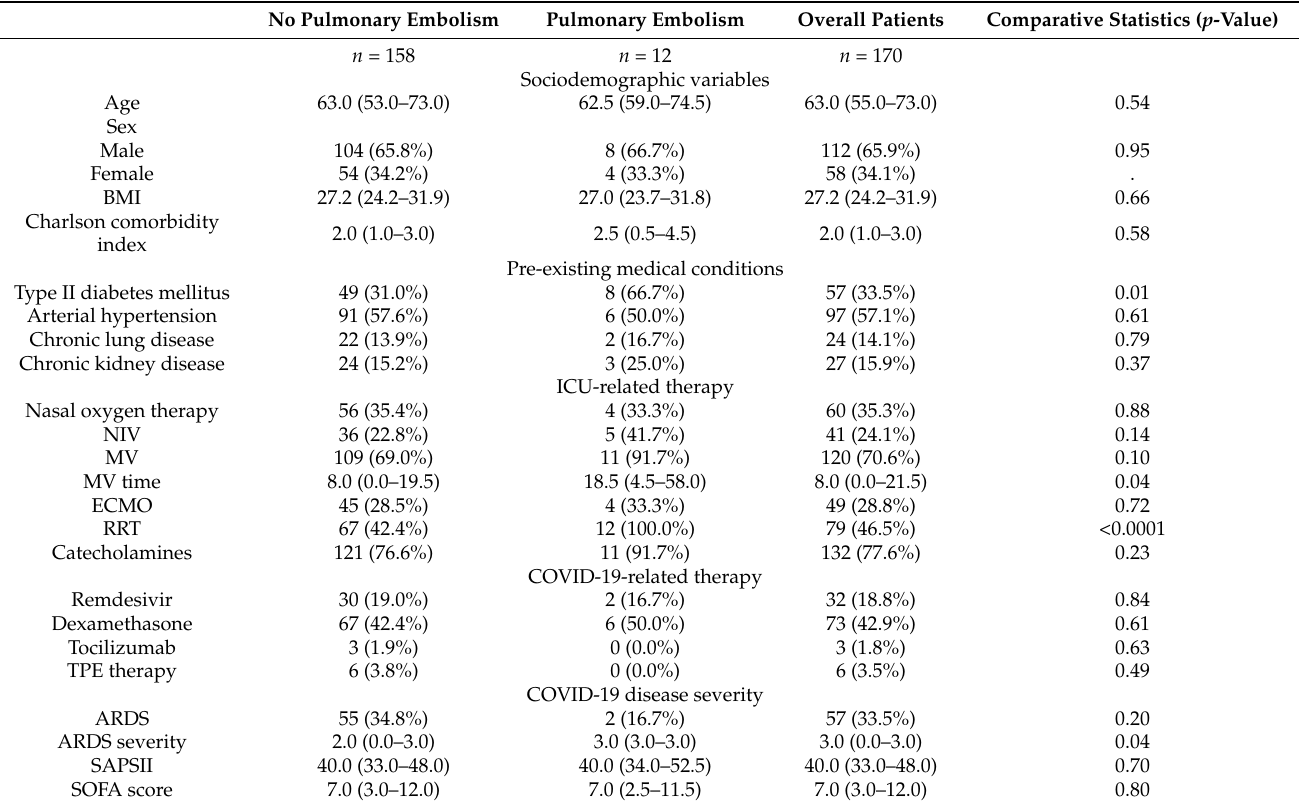
Table 3. Baseline characteristics of consecutive COVID-19 patients admitted to the Department of Intensive Care Medicine (University Medical Center Hamburg-Eppendorf, Germany) are illustrated ( n = 170). Patients were grouped according to the clinical diagnosis of pulmonary embolisms. Numbers with frequencies and median with interquartile ranges are illustrated. Abbreviations: BMI, body mass index; ICU, intensive care unit; NIV, noninvasive ventilation; MV, mechanical ventilation; ECMO, extracorporeal membrane oxygenation; ILA, interventional lung assist; RRT, renal replacement therapy; COVID-19, coronavirus disease 2019; TPE, therapeutic plasma exchange; ARDS, acute respiratory distress syndrome; SAPS II, simplified acute physiology score 2; SOFA, sepsis-related organ failure assessment